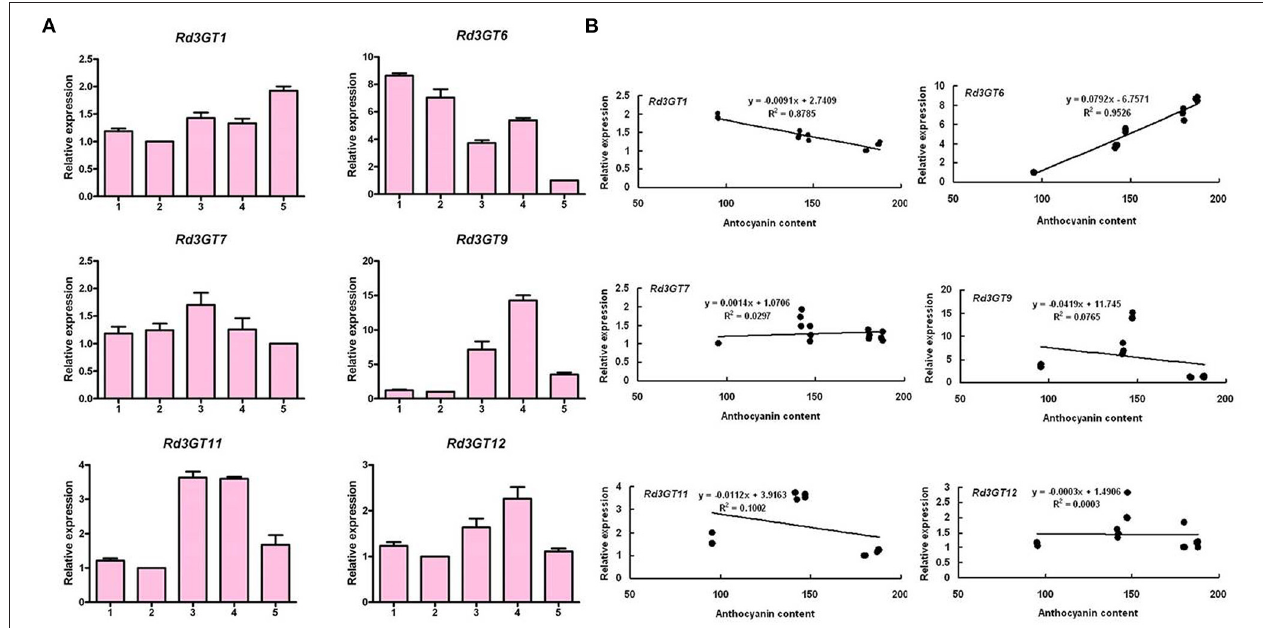
FIGURE 2 | Expression profiles of Rd3GTs during flower development (A) and Pearson’s correlation coefficient between Rd3GTs transcript levels and anthocyanin contents in R. delavayi flower (B) . 1–5 represent the flowers of different developmental stages.